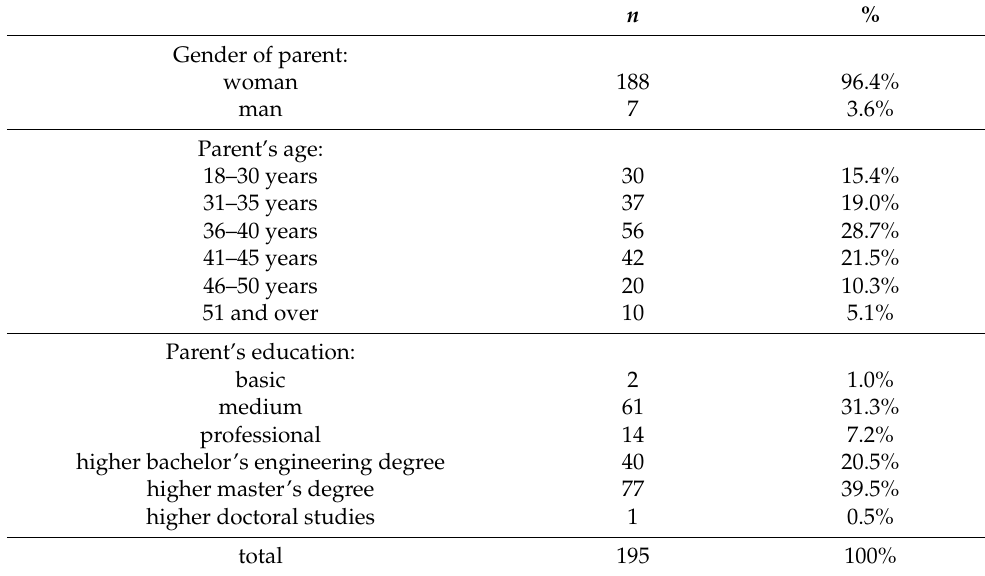
Table 1. Characteristics of the studied group of parents.